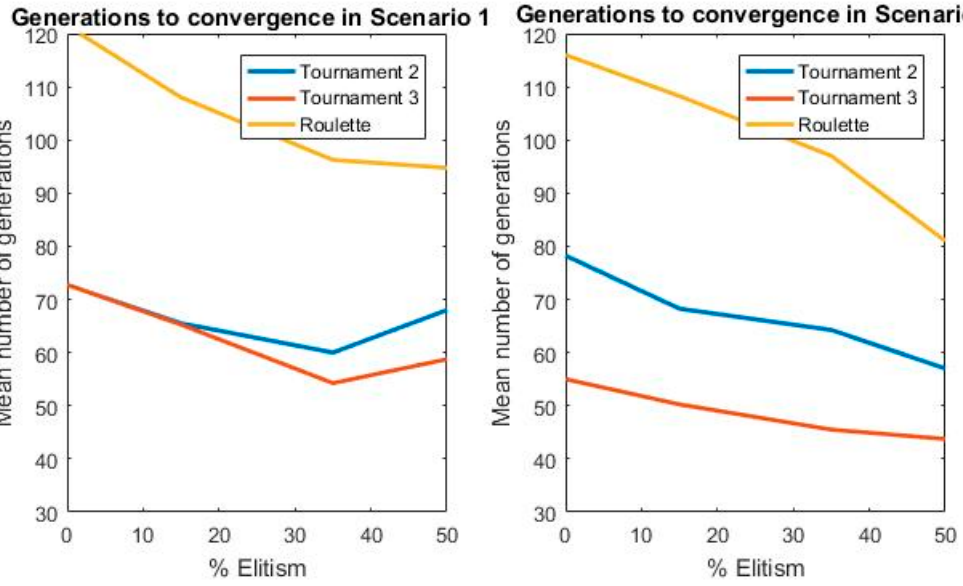
Figure 5. Convergence analysis in terms of elitism. In this picture, the number of generations that is needed to reach convergence is presented in Scenarios 1 and 2 in function of the percentage of elitism.